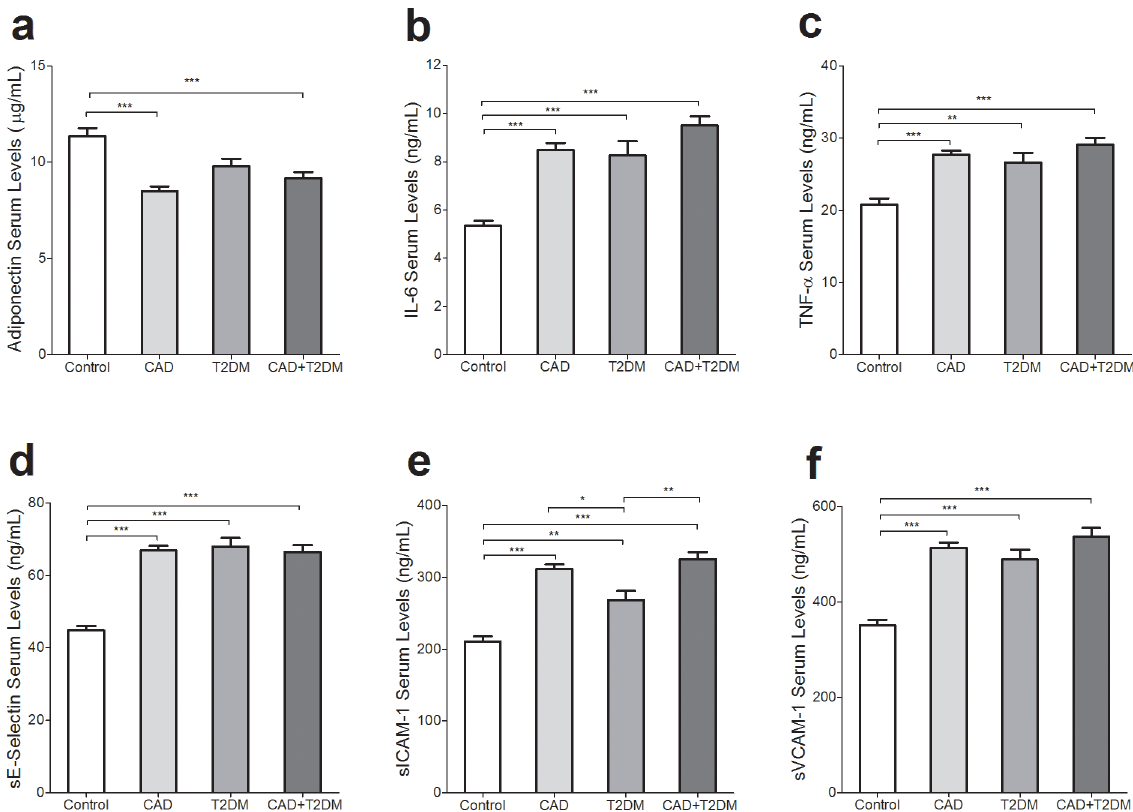
Fig 2. Circulating levels of adiponectin, inflammatory cytokines and soluble adhesion molecules in control, CAD, T2DM and CAD +T2DM category. a) A higher levels of serum adiponectin was demonstrated in controls compared to persons with CAD and CAD+T2DM (both, p < 0.001). b) Serum concentration of IL-6 was higher in patients groups compared to controls (all, p < 0.001). c) TNF- α concentration were higher in CAD, T2DM and CAD+T2DM category compared to control (all, p < 0.001). d) Those with CAD, T2DM, and CAD+T2DM showed a higher serum levels of E-selectin compared to control group (all, p < 0.001). e) sICAM-1 was higher in case groups compared to control (all, p < 0.01). Also, higher serum levels of sICAM-1 were shown in CAD (p < 0.05) and CAD+T2DM patients (p < 0.01) compared to T2DM group. f) Serum level of sVCAM-1 had higher levels in patients compared to healthy individuals (all, p < 0.001).